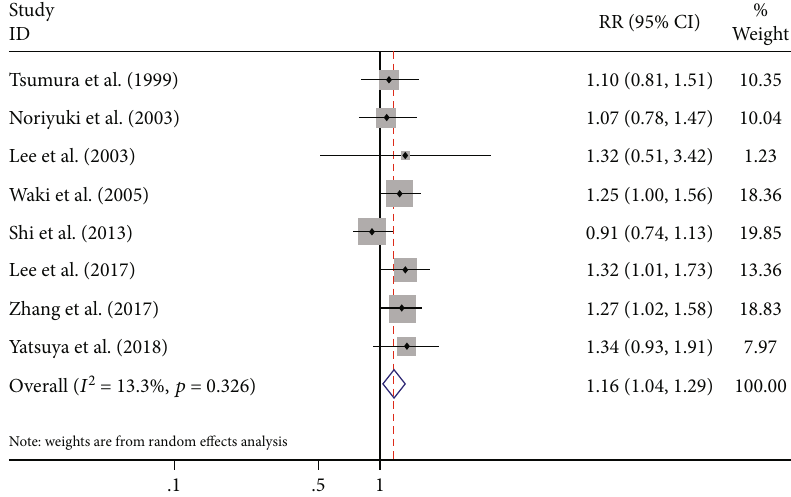
Figure 2: The forest plot of alcohol consumption and the risk of T2D in men. (highest vs. lowest).